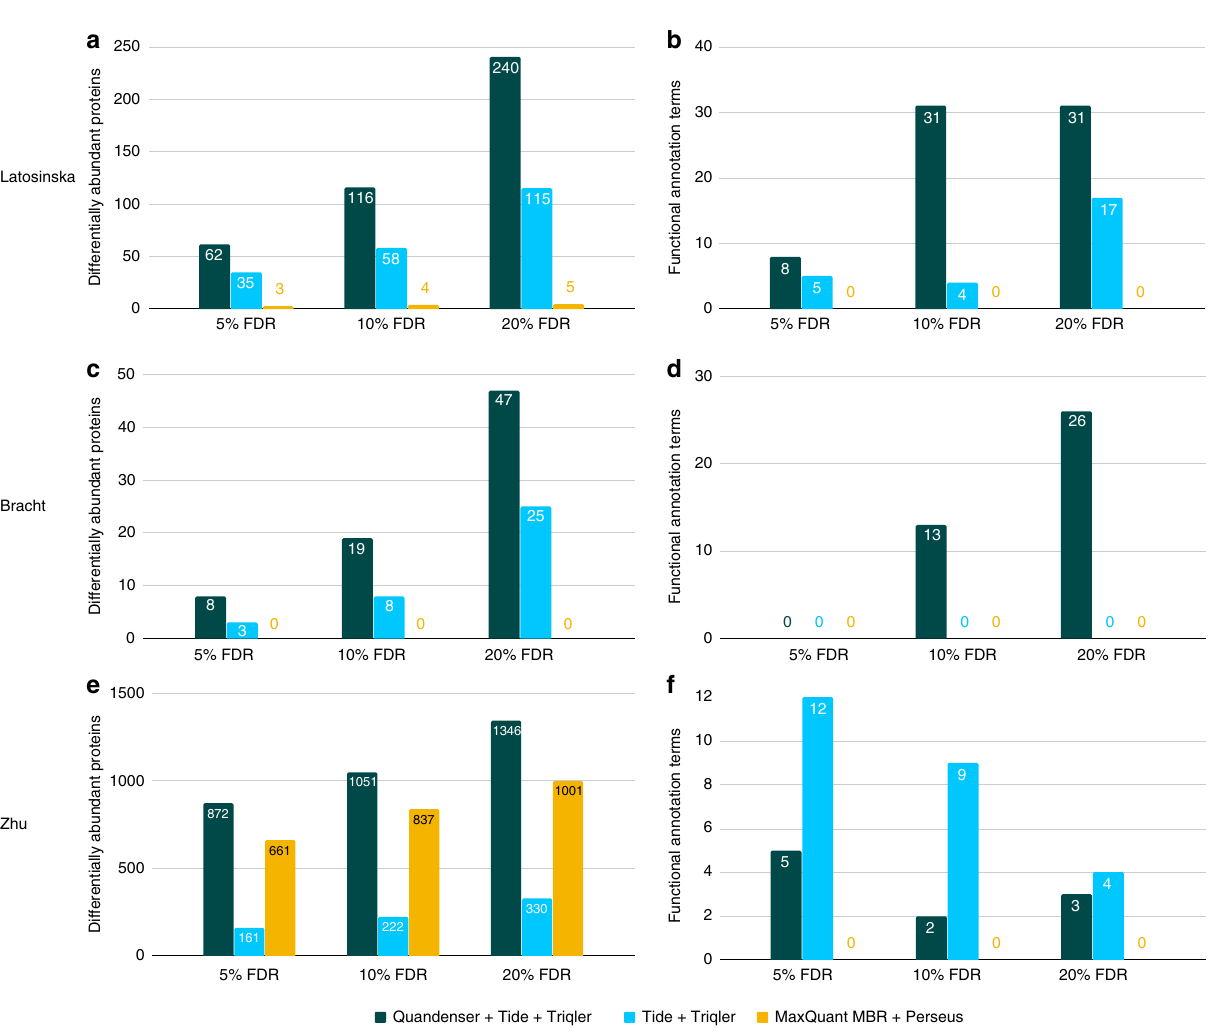
Fig. 3 Differentially abundant proteins and enriched functional annotation terms. The analyzed methods were our quanti fi cation- fi rst approach, Quandenser + Triqler when using the search engine Tide (green); and two identi fi cation- fi rst approaches, Tide and Triqler without clustering nor a match- between-runs (MBR) feature (light blue) and MaxQuant with MBR followed by statistical analysis with Perseus (yellow) when analyzing the Latosinska ( a , b ), Bracht ( c , d ), and Zhu ( e , f ) data sets. The left plots ( a , c , e ) show the number of differentially abundant proteins at three differential abundance FDR thresholds. The plots on the right ( b , d , f ) show the number of signi fi cant functional annotation terms we discovered with DAVID using the sets obtained in the left plots. Overall, we discovered more differentially abundant proteins and enriched functional annotation terms with than without Quandenser. Notably, Quandenser + Triqler with Tide found enriched functional annotation terms for the Bracht set for which no enrichments were previously found ( d ). Note that the FDRs reported in the plots on the right ( b , d , f ) refer to the differential abundance FDR and not the functional annotation term FDR, which was kept fi xed at